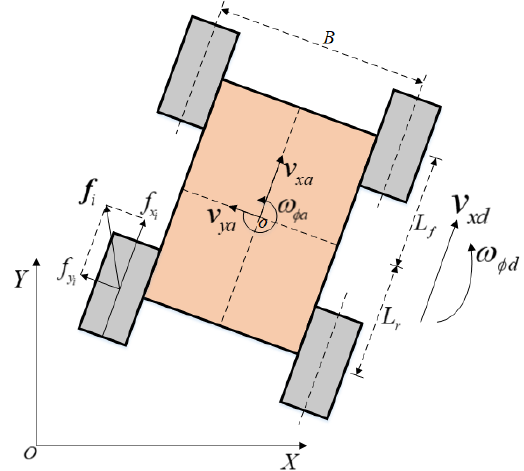
Figure 1. Skid-steering vehicle